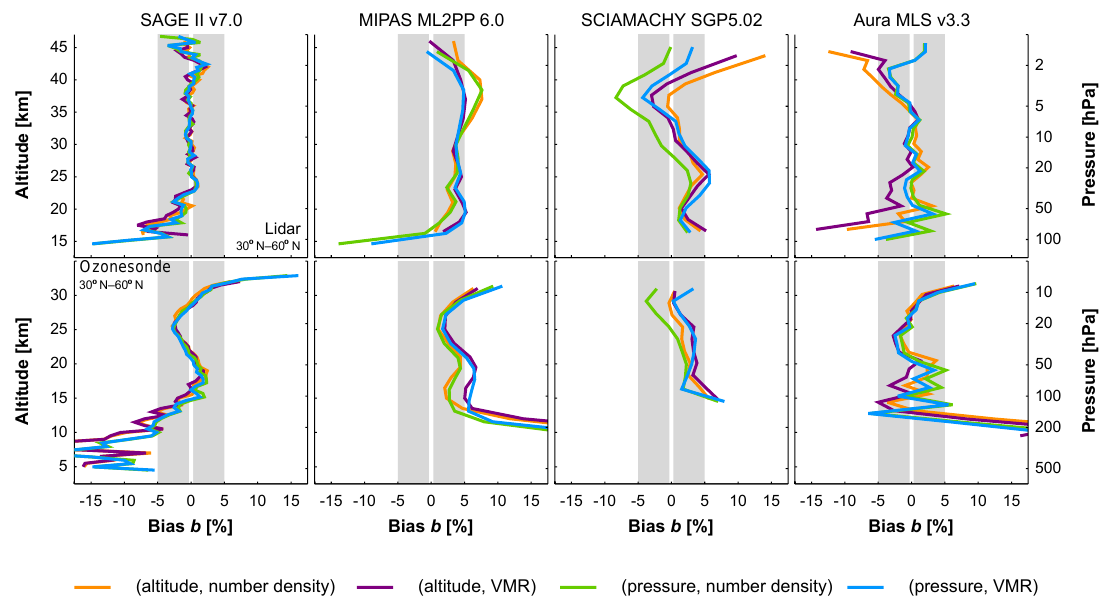
Figure 8. Dependence on profile representation of the bias of four satellite data records relative to lidar (top row) and ozonesonde data (bottom) at northern mid-latitudes. The satellite profiles are converted using the auxiliary information provided in the respective data files. The Supplement contains the results for all satellite records in five latitude